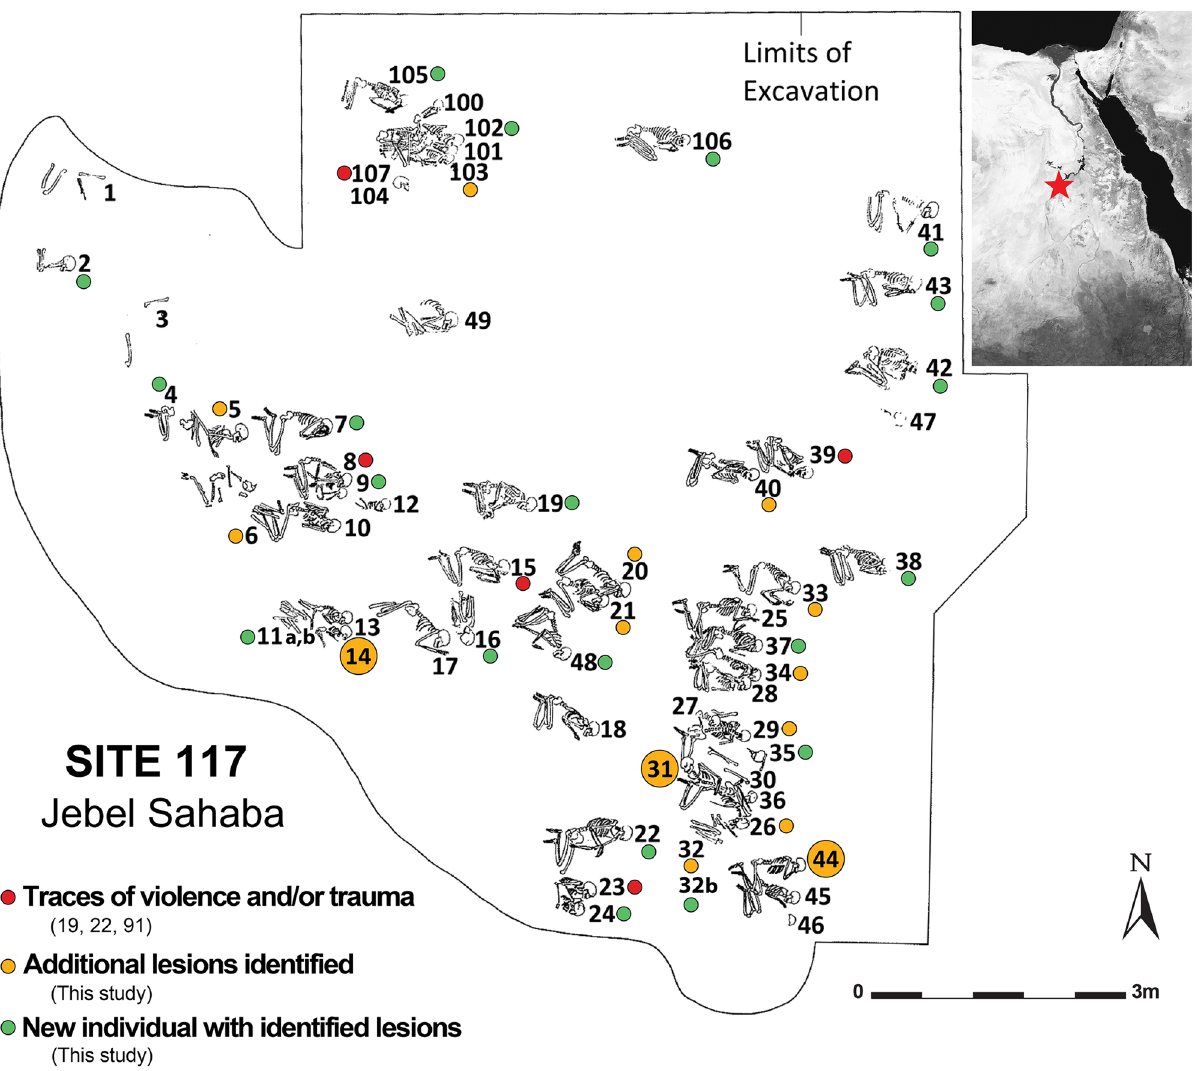
Figure 1. Location of the Jebel Sahaba cemetery, Site 117, in the Nile Valley and map of the excavated area and burials (map following 23 , Image Courtesy British Museum Wendorf Archive, modified with Adobe Illustrator CS6, https:// www. adobe. com/ produ cts/ illus trator. html). Red dots: individuals exhibiting signs of violence and/ or traumatic lesions 19,20,91 ; orange dots: newly identified lesions in the latter individuals; green dots: individuals newly identified as showing signs of violence and/or traumatic lesions; large dots: individuals discussed in detail in the text. Satellite image: Google Maps, 2020. 21° 58 ′ 12.0" N 31° 22 ′ 12.0" E, elevation 21.9 M. [online] Available through: <https:// www. google. com/ maps/ infra-cranium of JS 14 have unhealed trauma caused by projectile impacts (Fig. 2). The majority of the lesions are located on the calvaria and none had previously been documented. The frontal bone exhibits a blunt force trauma at the level of the glabella. Several drag marks and an oblong perforation are also present on the left side of the frontal squama, as well as scraping drag marks close to bregma. Both a puncture site with faulting and part of an embedded artifact are visible approximately one centimeter above the left orbit (Fig. 2-1). A perforation is also present on the right parietal and on the occipital. The frontal and occipital perforation exhibit internal bevelling consistent with projectile impacts 34 . A further set of marks is visible on the left femur, including two groups of drags on the antero-lateral border of the proximal part of the diaphysis (Fig. 2-2). The first group has two subparallel incisions with wide flat floors marked with parallel microstriations. Bone flaking is also present at the end of the trajectory. The second drag is located about one centimeter below the proximal one, and oriented slightly more anteriorly, with a bisecting pattern at the end of the marks. Based on these cutmark characteristics, the projectile most probably arrived from the medial side of the femoral diaphysis, in a downwards motion and towards the lateral side. The second case, JS 31, focuses on the remains of a probable male over 30 years old based on his heavy dental wear and bone remodeling. Seventeen lithic artefacts found in situ were in direct association with his skeletal remains, with two embedded in the bone and fifteen within the physical space of the body ( 23 , p. 973–974).